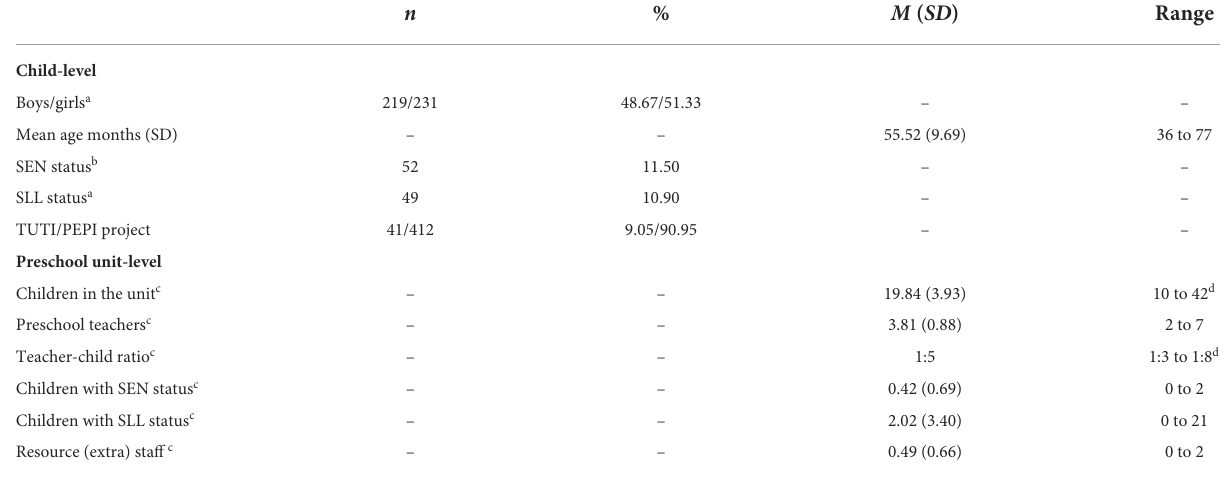
TABLE 1 Participant